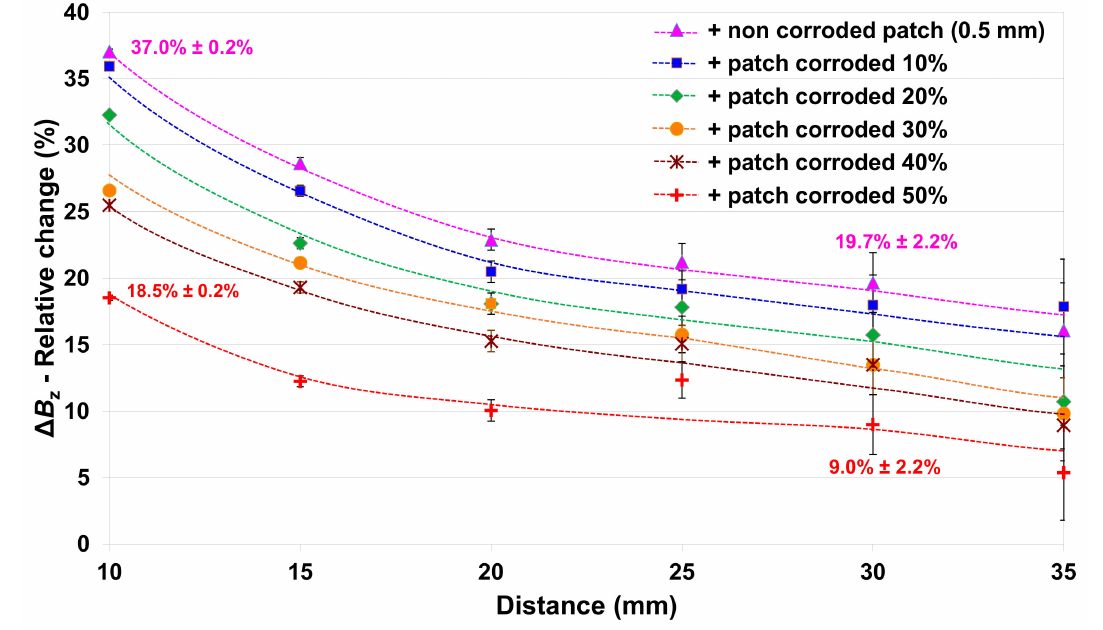
Figure 12. Relative change of B z , as a function of distance, for samples constituted with the 0.5 mm-thick